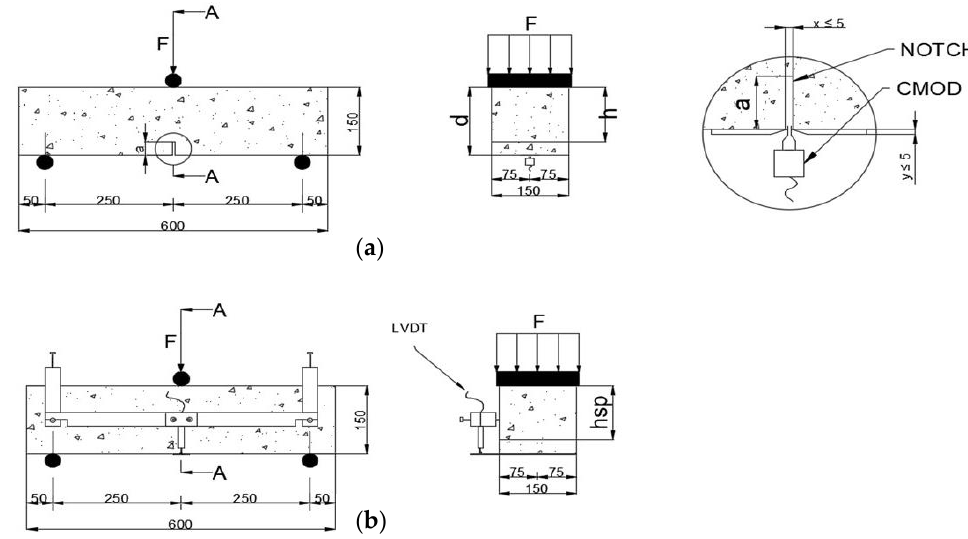
Figure 2. Configuration of the 3-point bending test, dimensions in mm. ( a ) Measurement of the crack-mouth opening. ( b ) Measurement of the displacement at midspan by an LVDT.